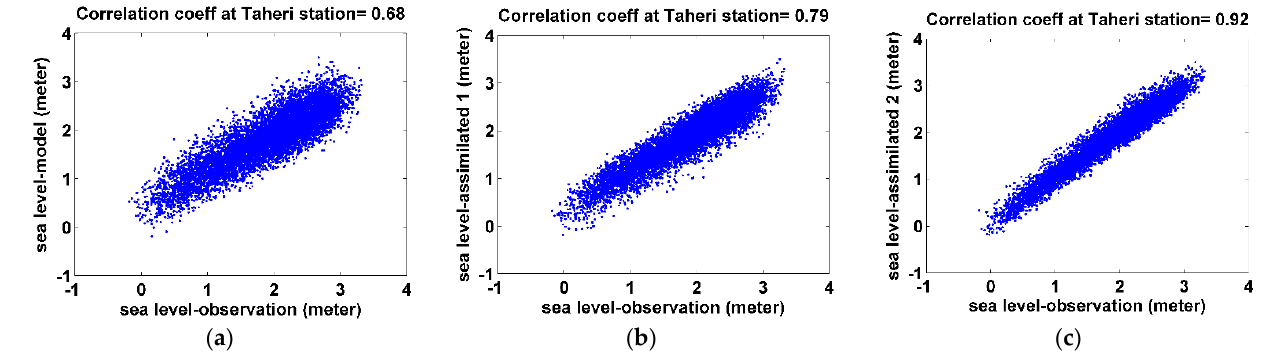
Figure 5. Correlations between the observations of the SLH at the Rajaei tide gauge station and the model output in three cases: ( a ) before data assimilation, ( b ) after data assimilation without considering the variance–covariance matrices, and ( c ) considering the variance–covariance matrices.